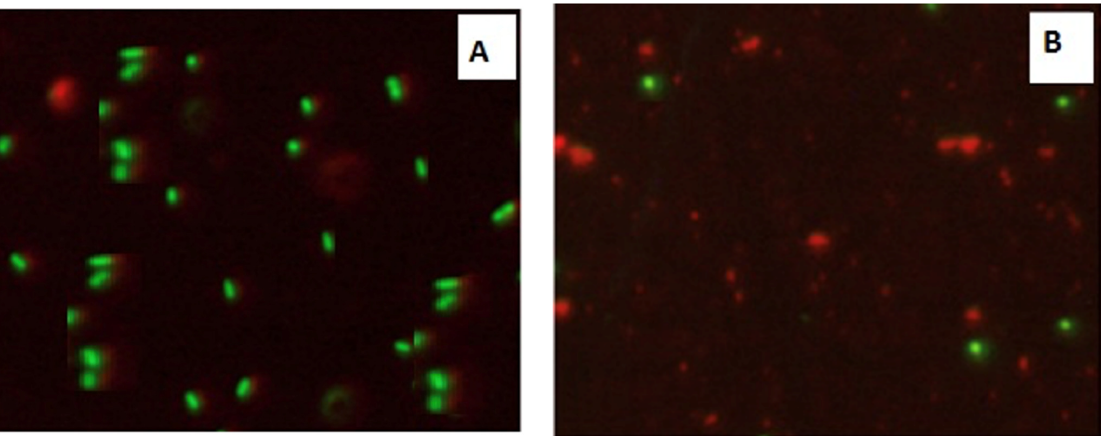
Figure 12. Minimum Inhibitory Concentration (MIC) and Minimum Bacterial Concentration (MBC) of CSNPs. HAPNPs against Streptococcus sanguis, Enterococcus faecalis, Streptococcus mutans, and Streptococcus salivarius.